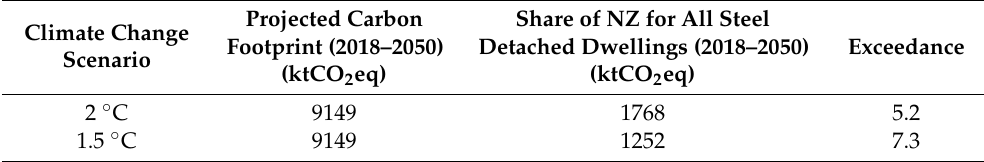
Table 5. Carbon budget exceedance calculated for 2 ◦ C and 1.5 ◦ C climate change